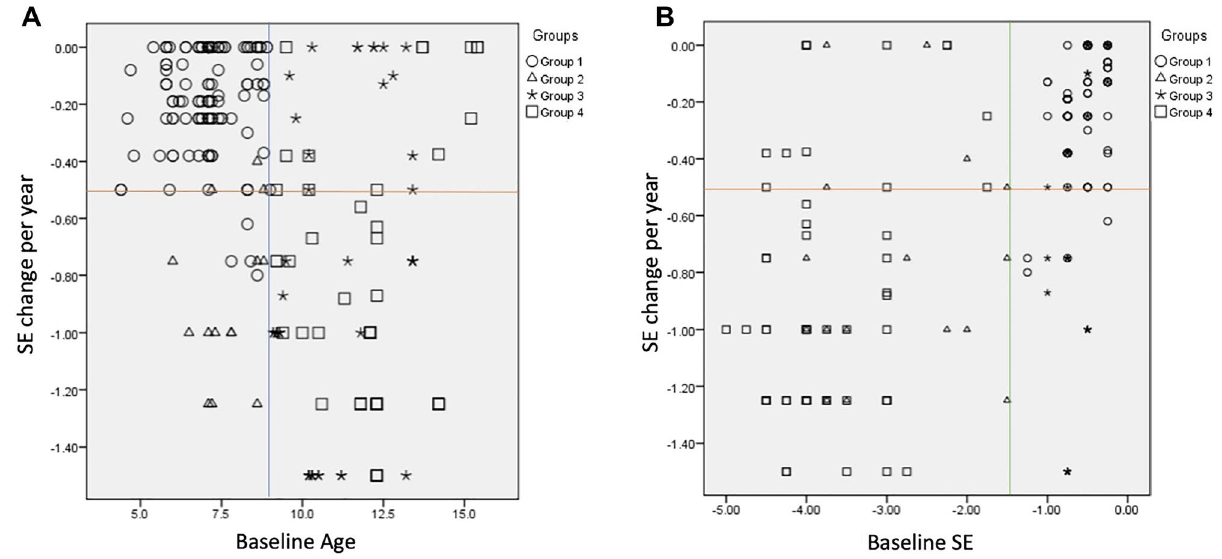
Figure 2. Scatter plots of all the study participants based on the cut-off points of a baseline age of 9 years (blue vertical line) and baseline spherical equivalent (SE) of − 1.5 D (green vertical line). ( A ) Plot of baseline age versus annual SE changes. ( B ) Plot of baseline SE versus annual SE changes. The orange line signifies the threshold of responders vs. non-responders for a half-diopter change